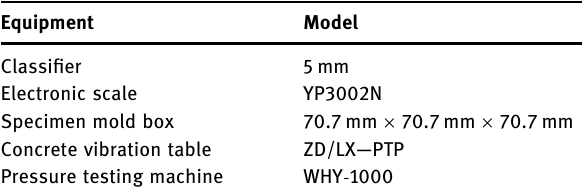
Table 4: Main test instruments and equipment Equipment